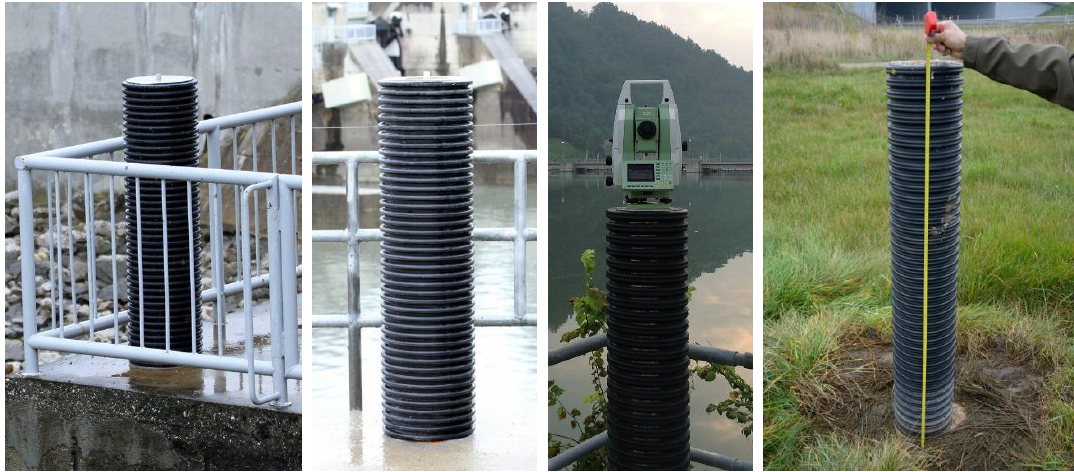
Figure 1. An example of an inappropriately stabilized measurement pillar.